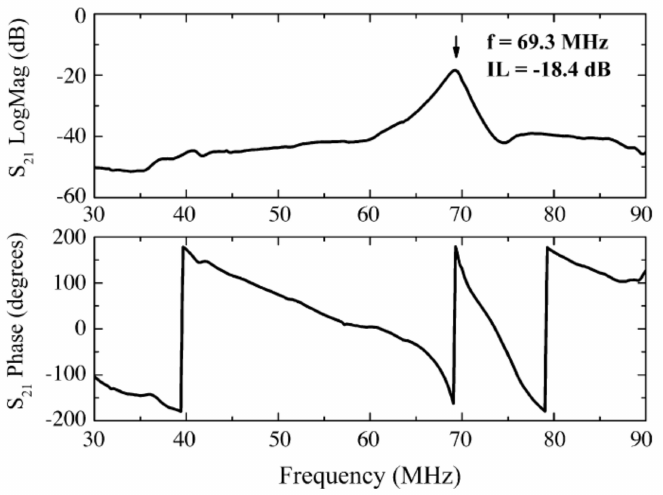
Figure 4. Typical S 21 transmission response (magnitude and phase of a layered ZnO/LiTaO 3 SAW two − port resonator with 10 monolayers LB 75 wt.% SWCNTs − in − CdA nanocomposite. Reprinted with permission from Ref. [62]. Copyright 2007